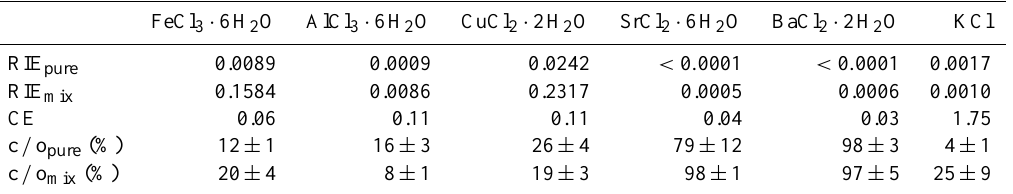
Table 2. Relative ionization efficiencies, CE values and c / o ratios for the metals from various metal halides measured during one set of experiments. RIE values were determined with two different approaches (RIE pure , RIE mix ) . CE values are calculated from the ratio of RIE mix to RIE pure . The measurement uncertainty is ∼ 15% for RIE and ∼ 20% for CE values. For the determination of RIE mix , most species were internally mixed with (NH 4 ) 2 SO 4 ; only BaCl 2 and SrCl 2 were mixed with NH 4 Cl.